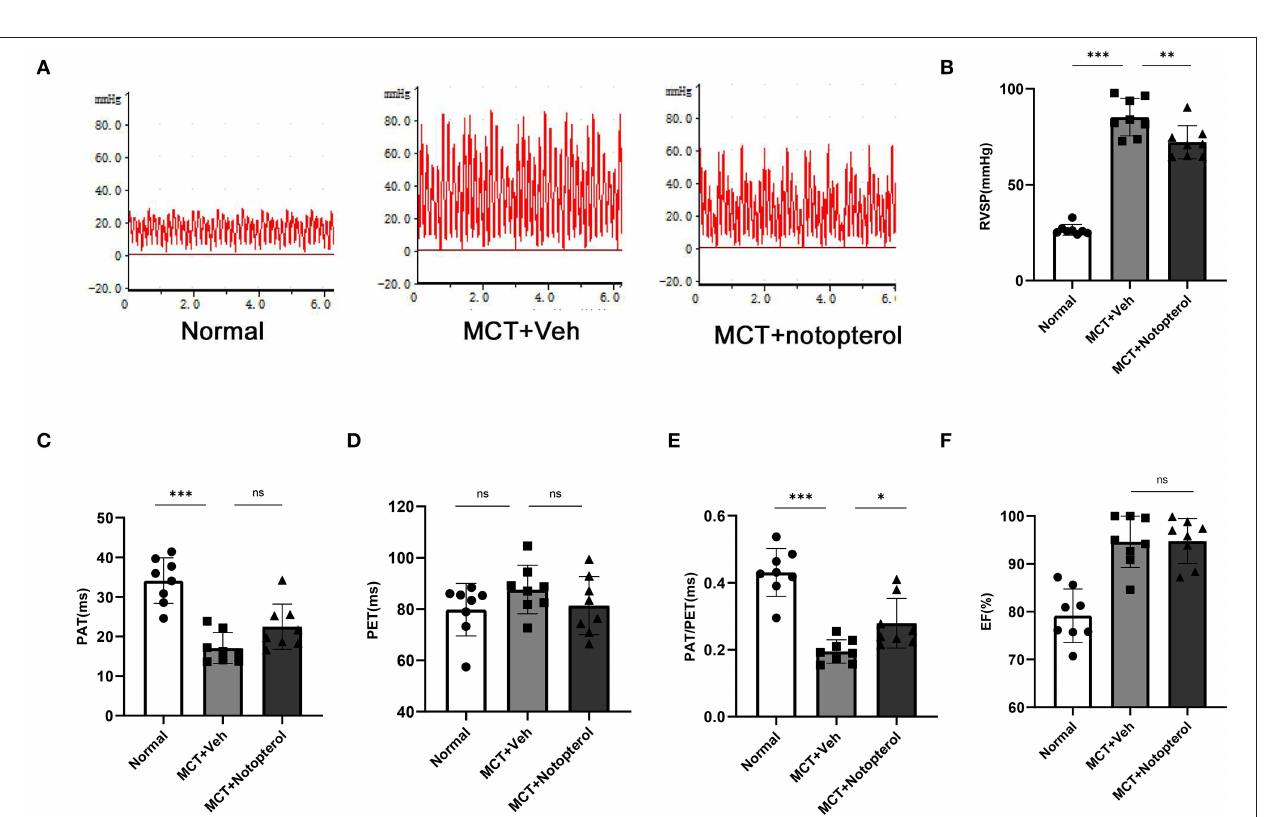
FIGURE 2 | Notopterol improves right ventricular function and reduces right ventricular systolic pressure in pulmonary arterial hypertension rats. (A) The right ventricular pressure waveform. Quantification of RVSP, (B) PAT, (C) PET, (D) PAT/PET, (E) LVEF, (F) 3 weeks after MCT injection ( n = 8 for each group); * p < 0.05, ** p < 0.01, *** p < 0.001. MCT, monocrotaline; Veh, vehicle; PAT, pulmonary blood flow acceleration time; PET, pulmonary ejection time; PAT/PET, pulmonary blood flow acceleration time/ pulmonary ejection time; RVSP, right ventricular systolic pressure.